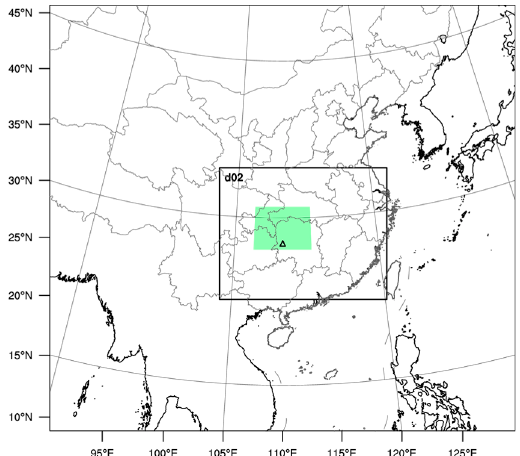
Figure 1. The model domains used. The outer region is the parent domain (9 km), and d02 is the inner domain (3 km). The innermost box, shaded green, denotes the area of the squall line system (approximately 27°–31°N, 107°–113°E), and the triangle at the bottom of the green area indicates the location of the Huaihua station.